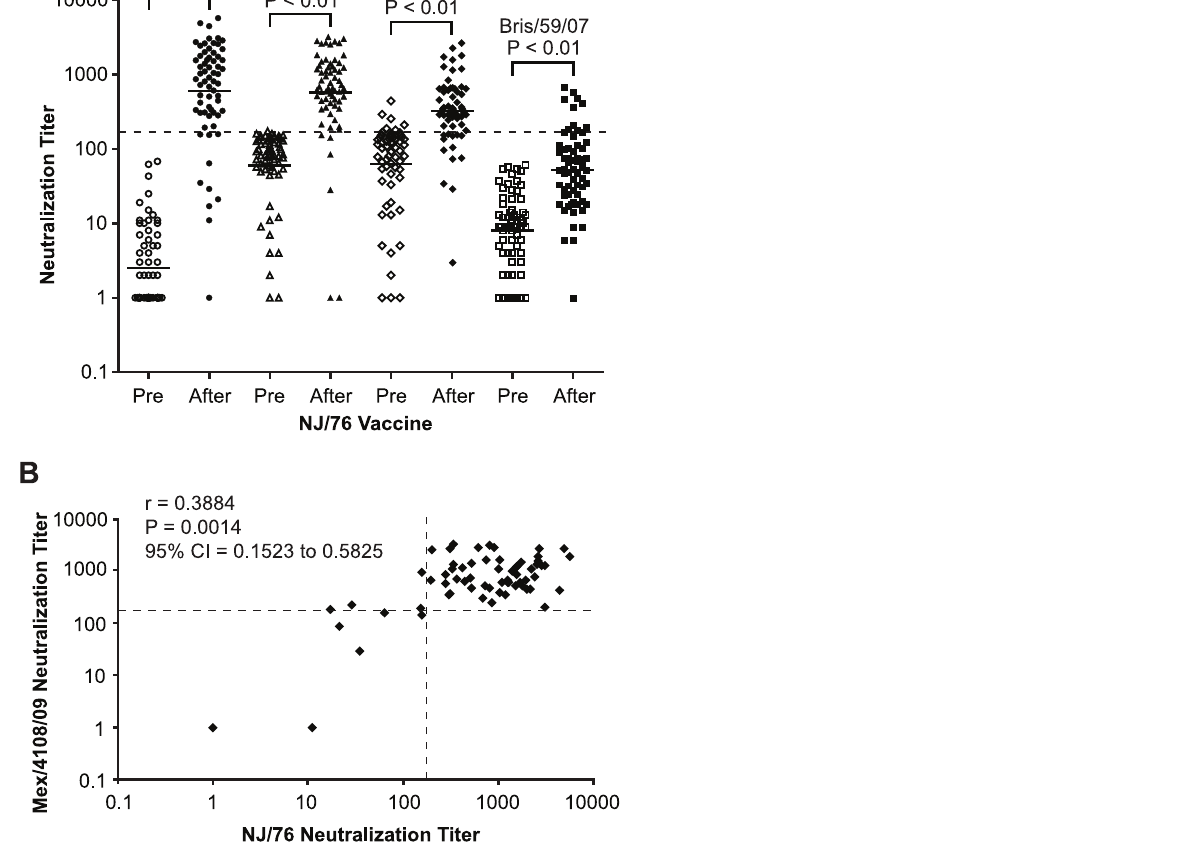
Figure 2. NJ/76 (swine flu) vaccination generates cross-neutralizing antibodies to 2009 H1N1 and seasonal influenza NCD/20/99. (A) Neutralization titers to NJ/76, Mex/4108/09, NCD/20/99 and Bris/59/07 in NJ/76 clinical trial sera collected pre and post NJ/76 vaccination are shown. The geometric mean of titers (GMT) of neutralization in each group is indicated by the short line. P values were calculated by the comparison of pre and post (after) NJ/76 vaccination with paired t test. (B) Correlation between NJ/76 and Mex/4108/09 neutralizing titers in the sera of after NJ/76 vaccination was evaluated with the Spearman test for nonparametric correlation. r: Spearman r; P: two-tailed P value. The dotted lines in both panels A and B represent the neutralization titer of 160, which has been proposed as a correlate of seroprotection in microneutralization assays involving replicating influenza virus [4]. Protective titers based on neutralization of HA-pseudotypes have not been determined.